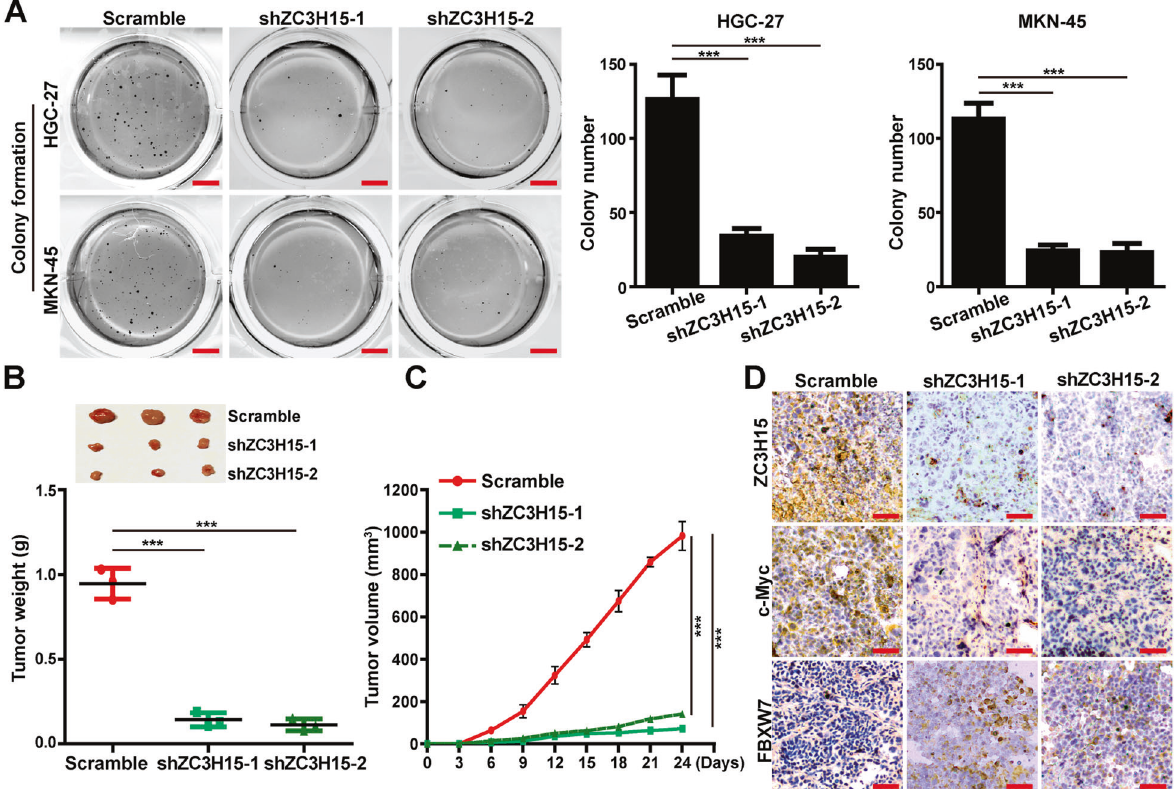
Fig. 7 ZC3H15 promoted the colony formation and tumor growth of GC cells. A Soft agar assays were performed to detect the colony formation ability of GC cells. B , C Xenograft assays were performed in ZC3H15-knockdown HGC-27 cells. The weight and volumes of tumors were analyzed and P -values were indicated. D Immunohistochemical staining assays were performed to detect the expression of ZC3H15, c- Myc, and FBXW7 in ZC3H15-knockdown tumor tissues and control tissues. All data were expressed as mean ± SD. Student ’ s t -test was performed to analyzed signi fi cance, * P < 0.05, ** P < 0.01, *** P <